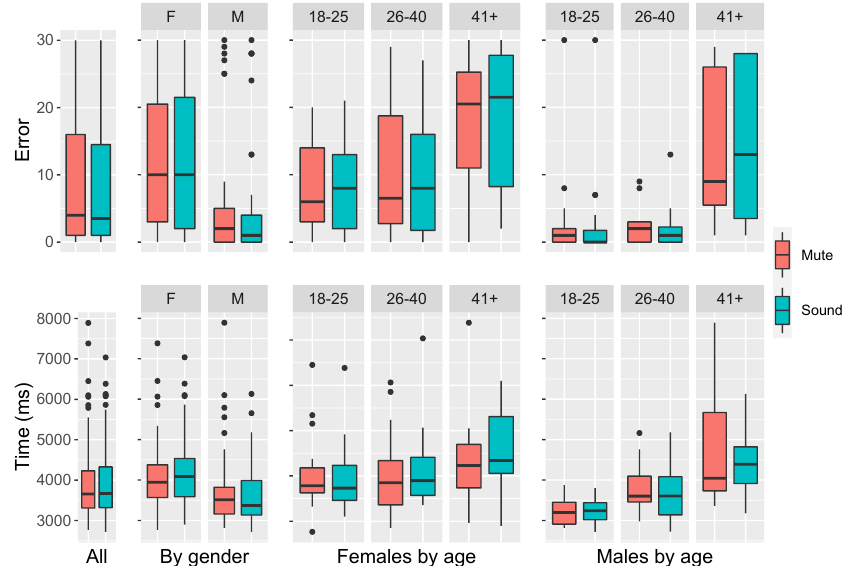
Figure 5. Boxplots showing error rate and time of activation by comparing “Mute” (red) and “Sound” (green) conditions for (1) all participants, (2) by gender, and (3) by gender and age. None of differences are